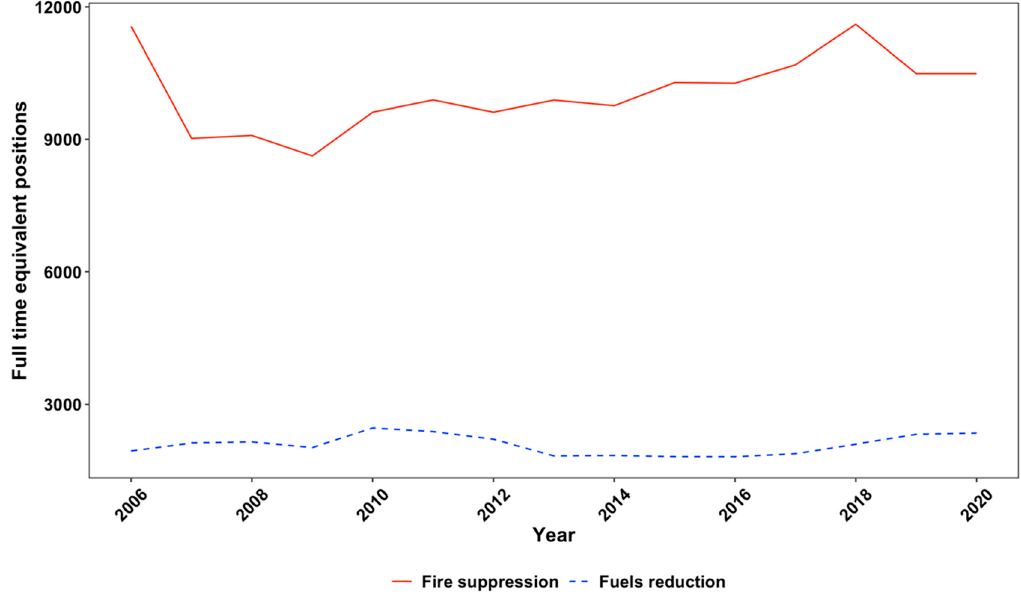
Figure 6. United States Forest Service full time equivalent positions for fire suppression (in red) and fuels reduction (in blue), 2006–2020.